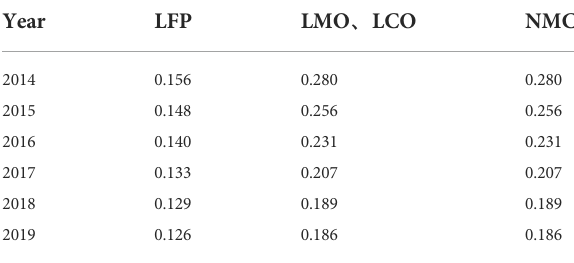
TABLE 1 Lithium consumption intensity of lithium batteries by type in China, 2014 –